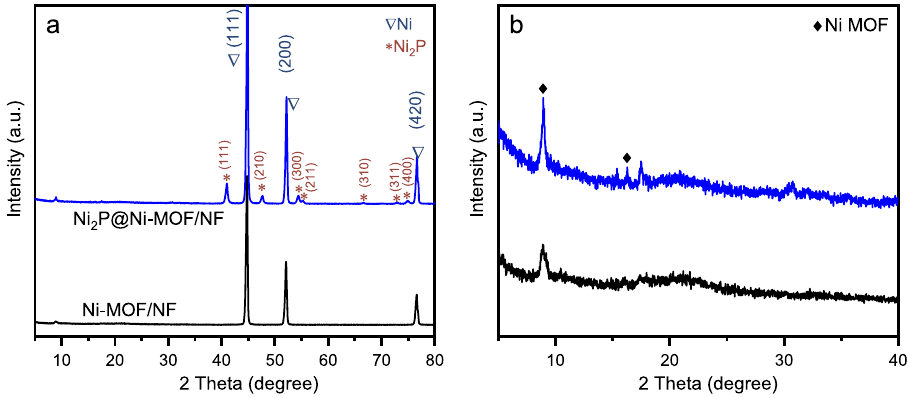
Figure 1. ( a ) Powder XRD pattern of Ni-MOF/NF and Ni 2 P@Ni-MOF/NF and ( b ) enlarged XRD pattern on an expanded y-axis